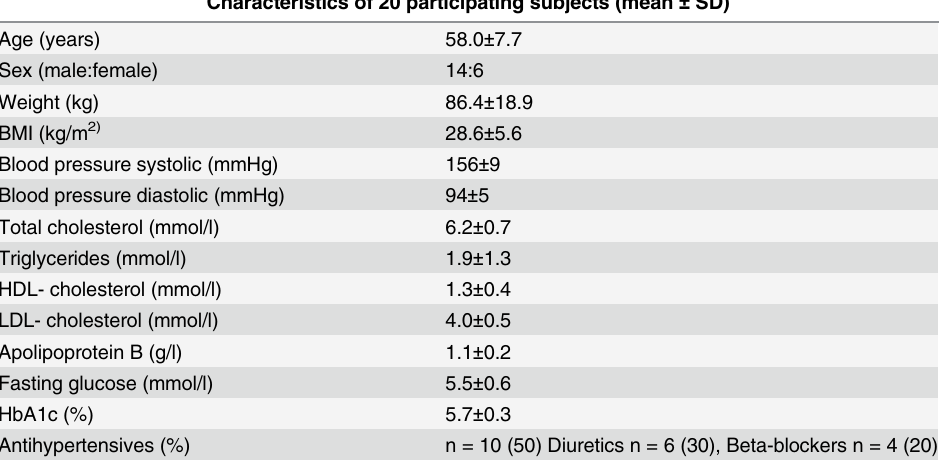
Table 1. Baseline